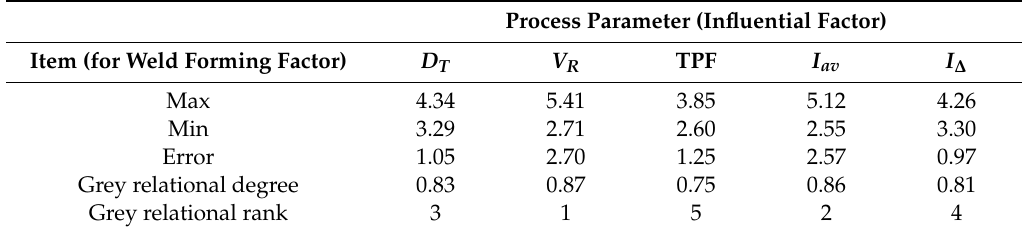
Table 8. Grey relational analysis of weld forming factor and process parameters.